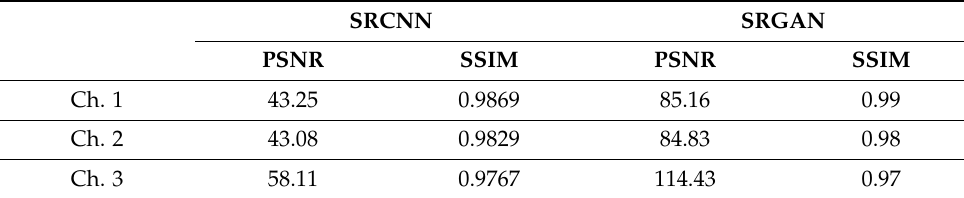
Table 1. Quantitative measures with Ch. 1–3.